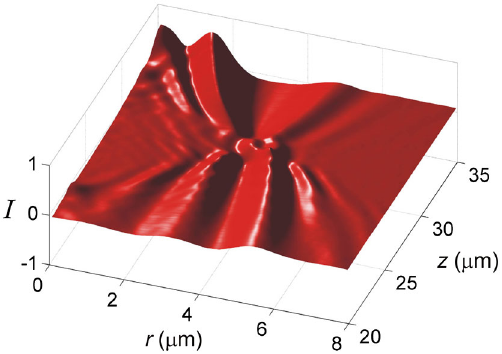
FIG. 2. Surface plot of the normalized radial intensity profile of a spherical particle as a function of the particle position relative to the bottom substrate. The focal depth of the micro- scope is fixed at z ¼ 28 (cid:1) m . By generating a z -stack fingerprint of each particle and using a least-squares-fitting procedure, the particle position can be determined with 20-nm precision over a range of tens of micrometers in any direction without needing to readjust the